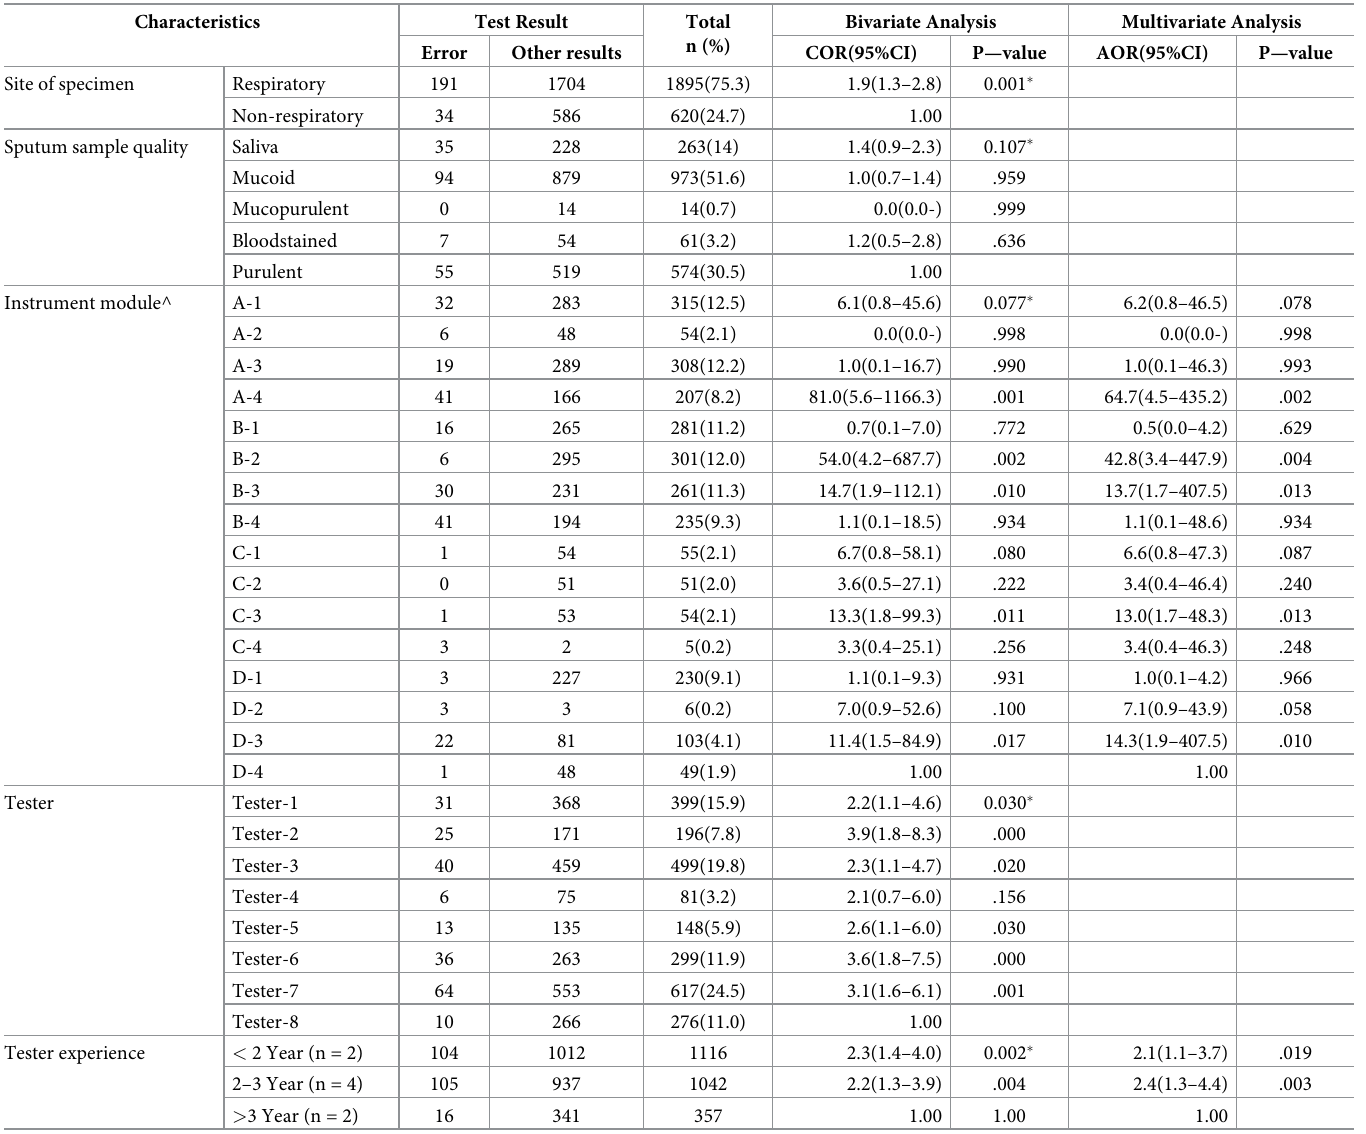
Table 7. Risk factors associated with Xpert MTB/RIF error